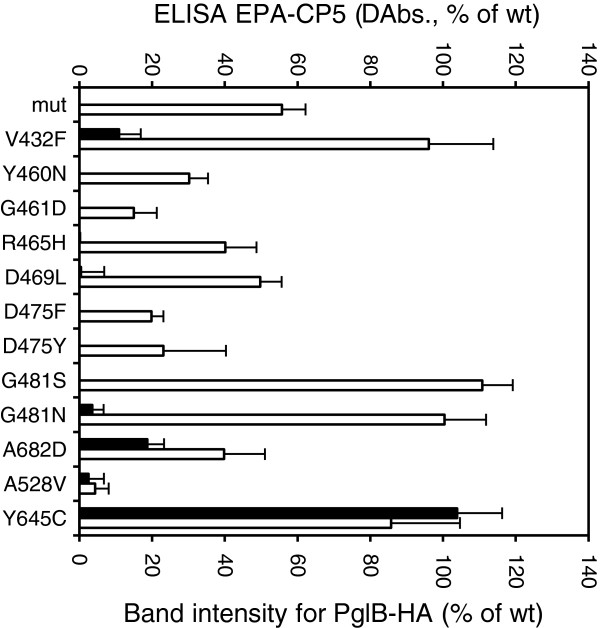
Relative levels of glycoprotein and PglB expression in epPCR variants. EPA-CP5 levels in periplasmic extracts of deep well plate cultures were determined by sandwich ELISA (solid bars, left y-axis, wt = 100%). ELISA signals were corrected for absorbance of PglB mut control wells (ΔAbs. 450 nm). PglB production was analysed by anti-HA Western blot of total cell protein samples (open bars, right y-axis, band intensity of wt = 100%). Average values and standard deviations of three replicate deep well cultures.